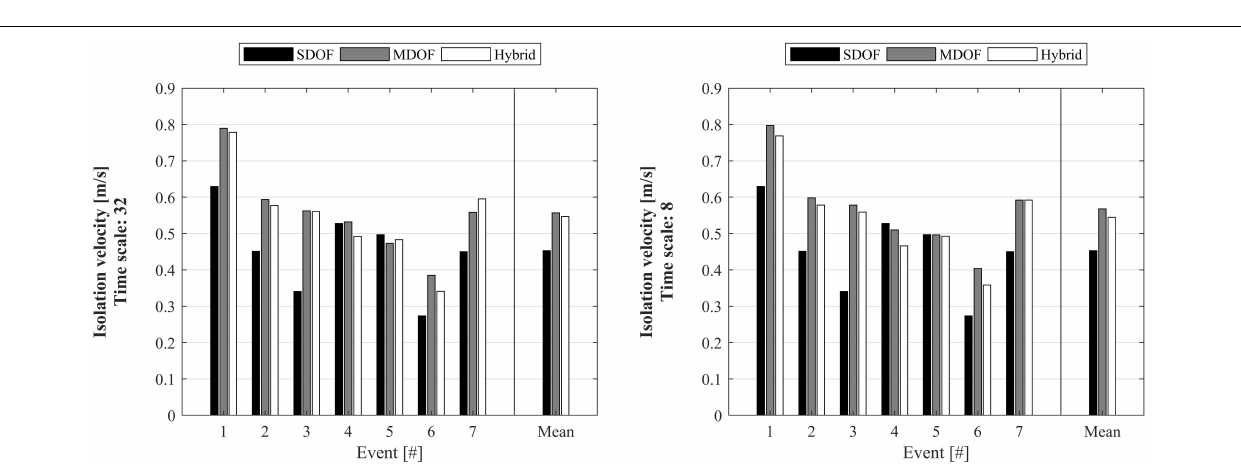
FIGURE 9 | Isolation displacement response—time scales 32 and 8.